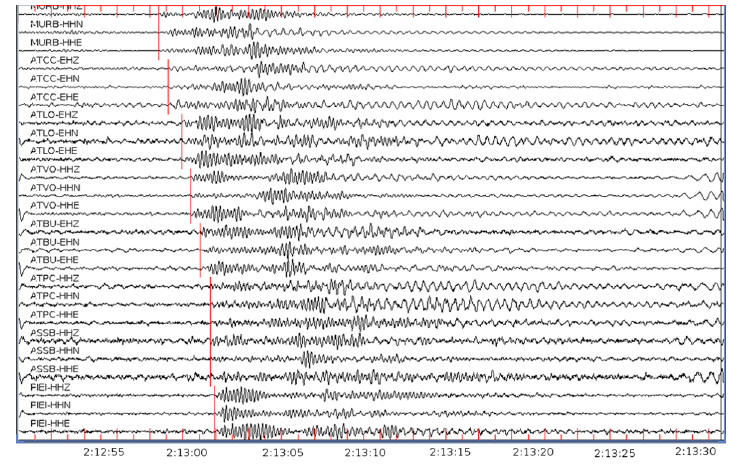
Figure 8. Example of a “low frequency” event in the Ghigiano area. The nearly monochromatic character and the lack of S waves are evident. Source area